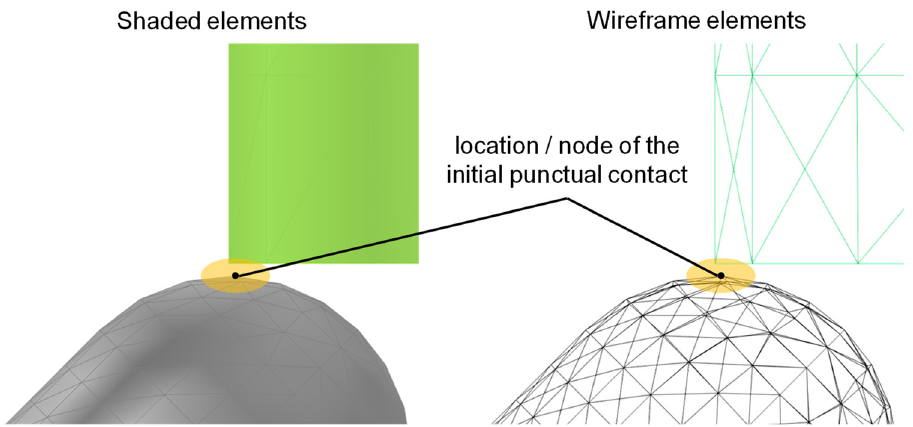
Figure 5. Detailed view of the FE model for the forming of the adaptive joining element to illustrate the initial punctual